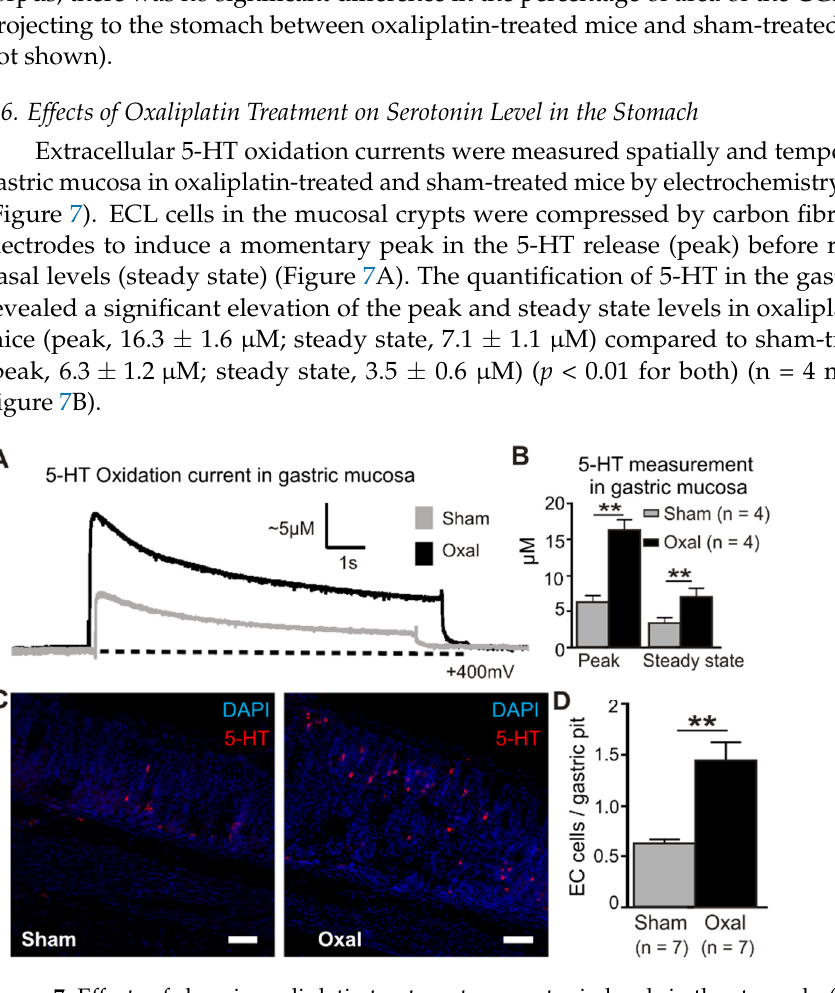
Figure 7. Effects of chronic oxaliplatin treatment on serotonin levels in the stomach. ( A ) Representative amperometric traces of the current generated by serotonin (5-hydroxy tryptamine (5-HT)) oxidation at the mucosal surface of the stomach. The current (nA) was converted to 5-HT (µM) by calibrating carbon fibre electrodes with a 10 µM 5-HT solution, as depicted in vertical scales. Mechanical stimulation of the gastric mucosa produced a compression-evoked release (peak) of 5-HT, which decayed back to basal levels (steady state) in both sham (grey traces) and oxal-treated mice (black traces). The dotted lines represent the baseline. ( B ) Group data comparing ‘peak’ and ‘steady state’ 5-HT levels between sham and oxal-treated mice. ( C ) ECL cells visualised by fluorescent immunohistochemical detection of 5-HT (red) in the mucosa of the gastric body (scale bar = 50µm). ( D ) Quantification of ECL cells (5-HT + ve) in the gastric body of sham- and oxal-treated mice normalised per number of gastric pits. Data are presented as the mean ± SEM. The number of animals is shown in parentheses. ** p < 0.01.